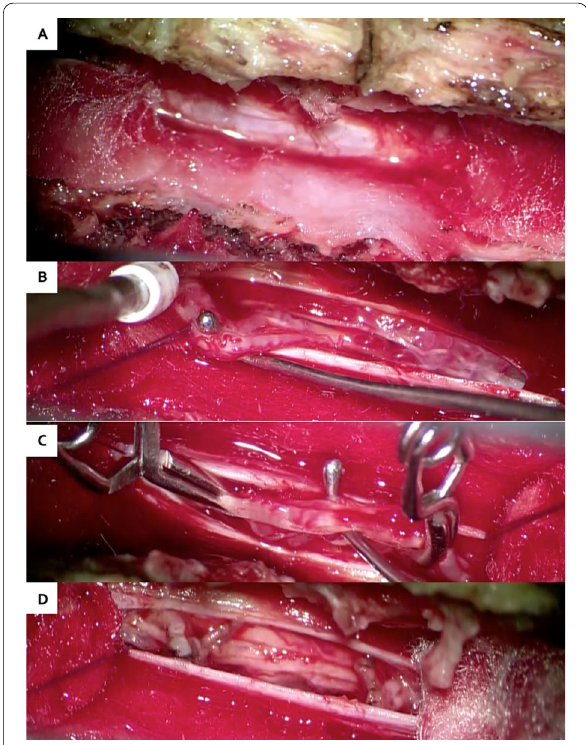
Fig. 2 Intraoperative image finding ( A ) a left-sided hemilaminectomy on Thoracal 11th and 12th level, showing ( B ) tortuous vessels on the dorsal surface of the conus medullary, ( C ) arterial feeder and draining vein were temporarily clipped, ( D ) post-resection evaluation showed enough decompression of the nerve root